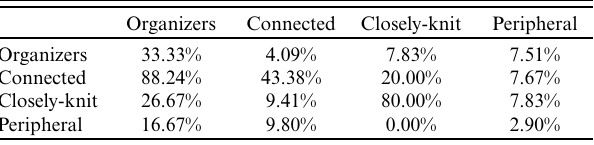
Table 1 . Density of intra and